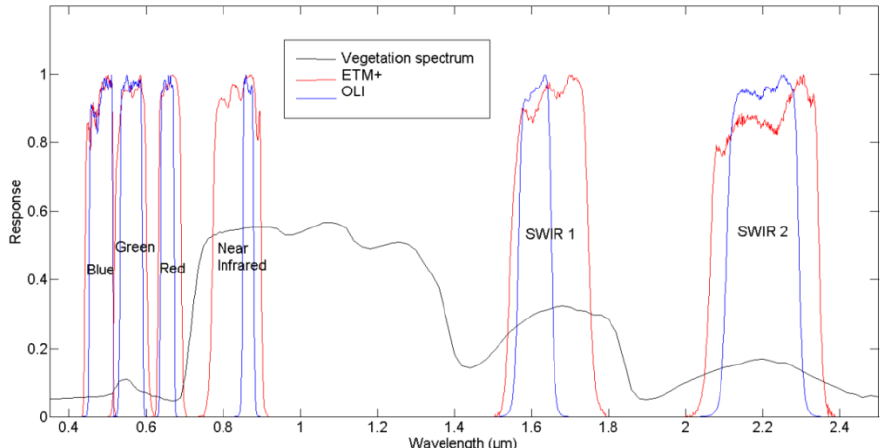
Figure 3. Spectral response function (SRF) associated with the visible, near-infrared (NIR) and shortwave infrared (SWIR) bands of the ETM+ and OLI. Red lines indicate the ETM+ sensor and blue lines indicate the OLI sensor. The black line indicates a deciduous forest spectrum as a